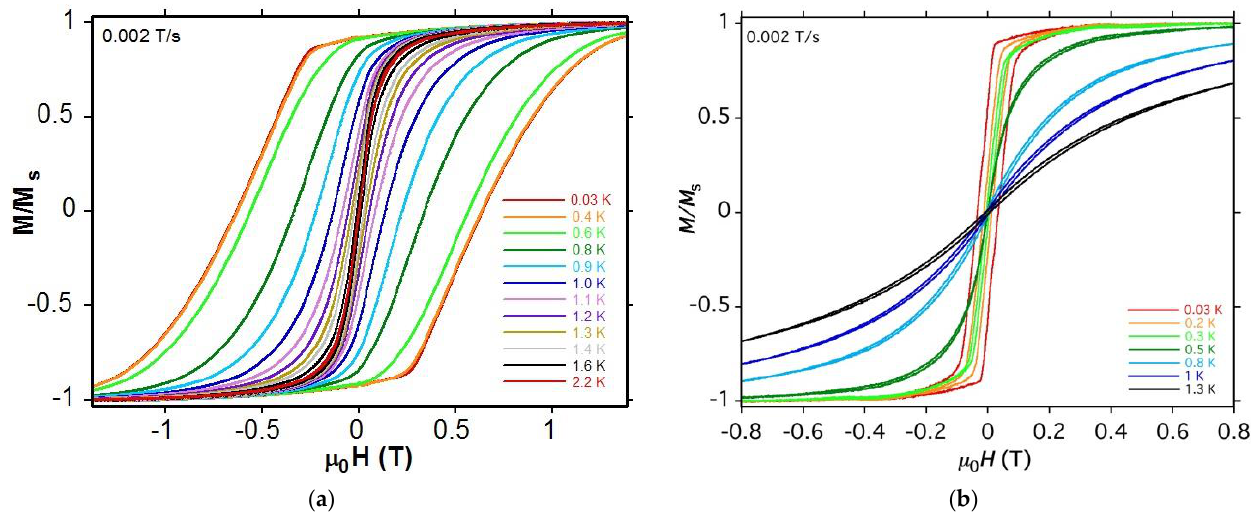
Figure 17. Field dependencies of the normalized magnetization measured at low temperatures from oriented single crystals with the H dc applied along the easy axis: ( a ) for 12 ; ( b ) for 13 [46].